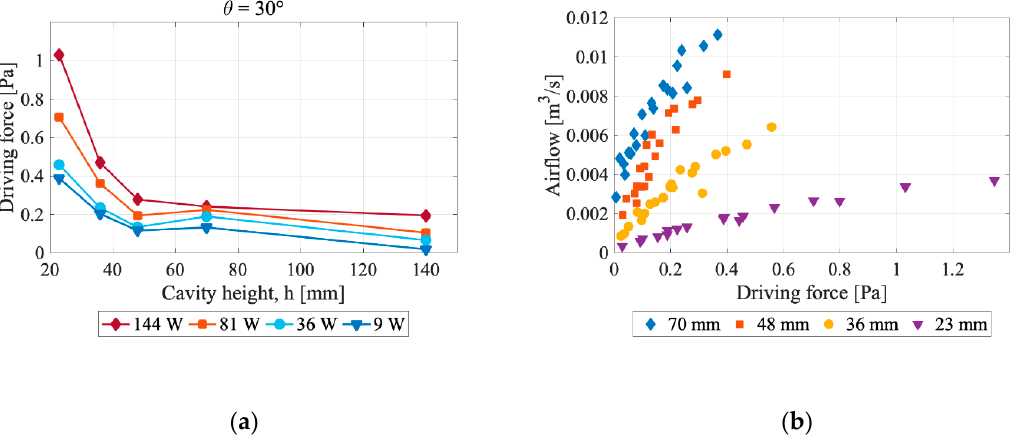
Figure 11. ( a ) Driving force as a function of cavity height at a roof inclination of 30°; ( b ) airflow rate and driving force for different air cavity heights. Measurements at all roof inclinations are included in the diagram.